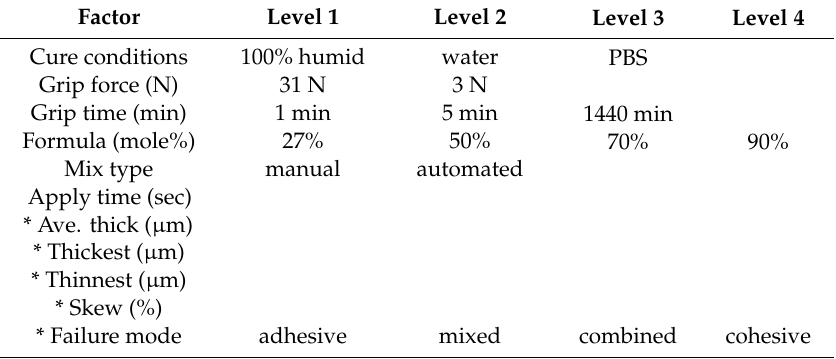
Figure 1. Overview of the experimental design. ( A ) A visual representation of the shear test on metal cubes and adhesive (top), and an image of the shear test rig after testing (bottom, tested samples indicated with arrows). ( B ) An analysis of the tested samples, including measurement of the bond thickness (T Ave ), bond unevenness ( ∆ T Max ), and failure mode (f Mode ) (top), and of the failure interface (bottom, scanning electron microscopy (SEM) image). ( C ) The measured factors were used in scatter plot analysis, and to build a linear regression model. Table 1. Fixed factors and covariates for linear regression and scatter plot analysis.